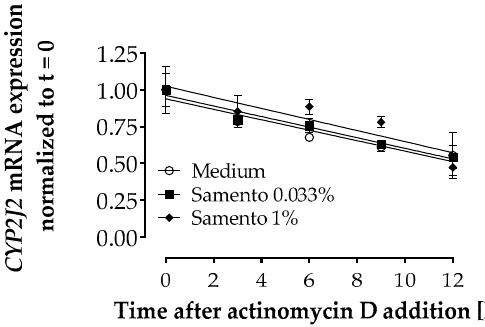
Figure 6. Effect of Samento on CYP2J2 mRNA decay in LS180 cells. Cells were pre-treated with Samento (0.033 or 1%) or medium only for 12 h. Transcription was then inhibited by addition of 5 µ g/mL actinomycin D and cells were harvested and RNA extracted after 3, 6, 9, or 12 h of treatment. Expression of CYP2J2 mRNA was quantified by RT-PCR and results normalized to β 2mg and to t = 0. Data are expressed as mean ± S.E.M. for n = 3 biological replicates.